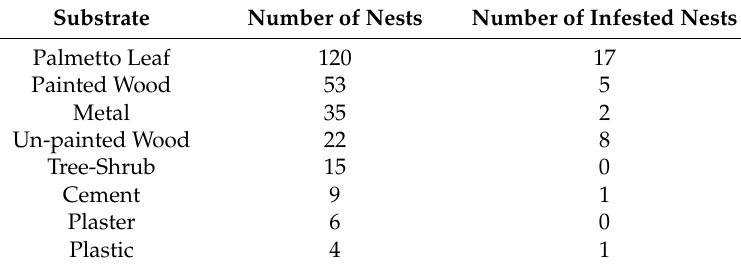
Table 2. Number of nests and nests infested with C. iphitalis per substrate in field colonies of Polistine